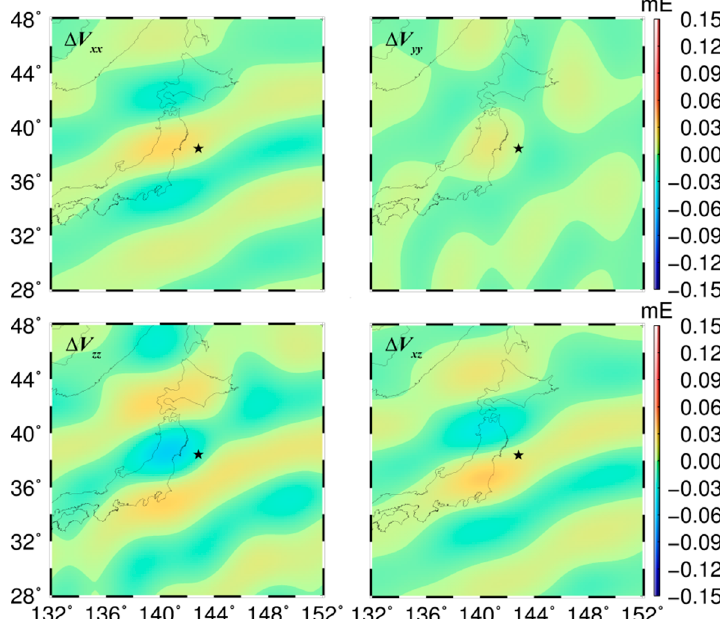
Figure 10. Gravity gradient changes ( Δ V xx , Δ V yy , Δ V zz , and Δ V xz ) in Local North-Oriented Frame on a sphere with a height of 260 km computed by the tailored spherical harmonic coefficients from GRACE. The SH degree range is 30–95. The units are mE.